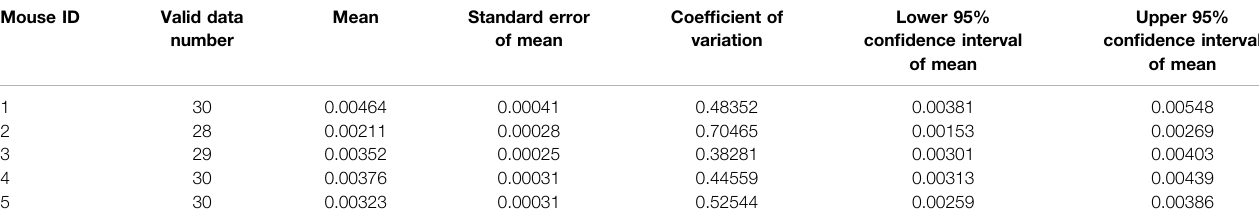
TABLE 2 | Statistical analysis of initial permeability rate of each BALB/c mouse injected with 40 kDa FITC-dextran. Mouse ID Valid data